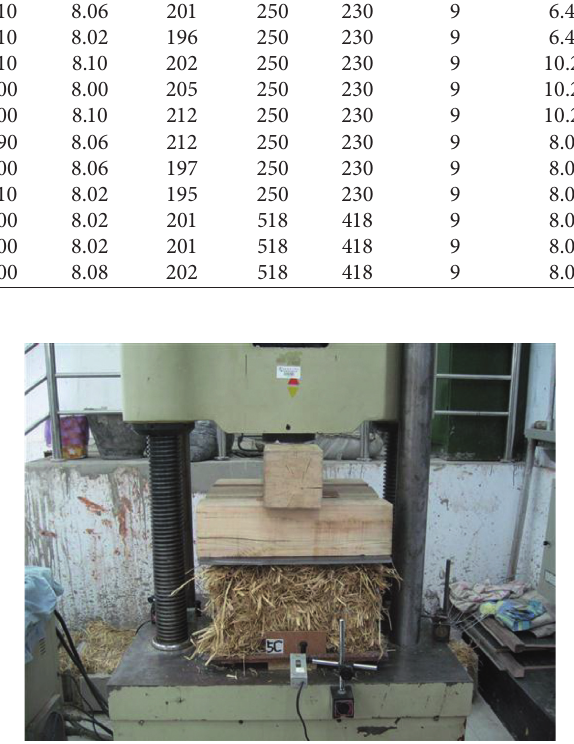
Figure 4: Setup and displacement sensors.